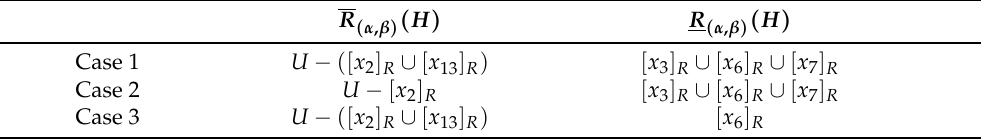
Table 7. The upper and lower approximations under different cases in the VPRS-HFEn